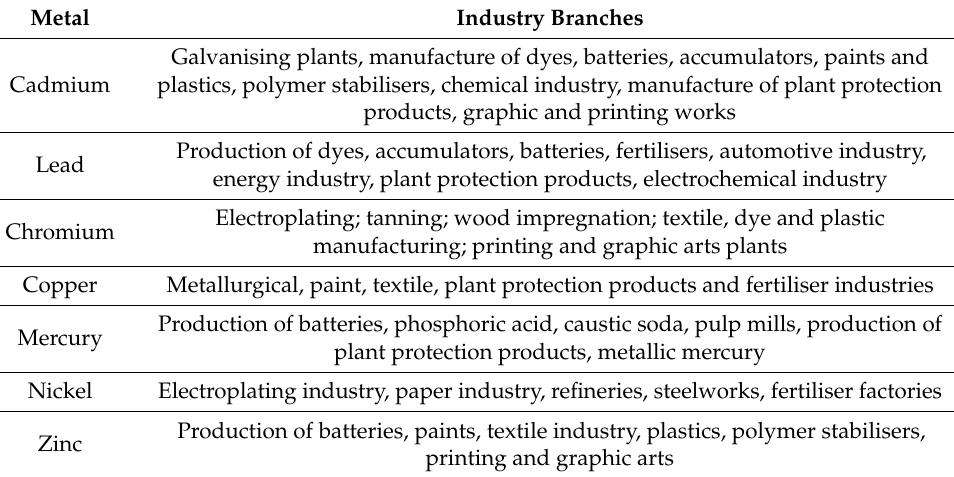
Table 2. Industry branches which are a source of heavy metal emissions to the environment